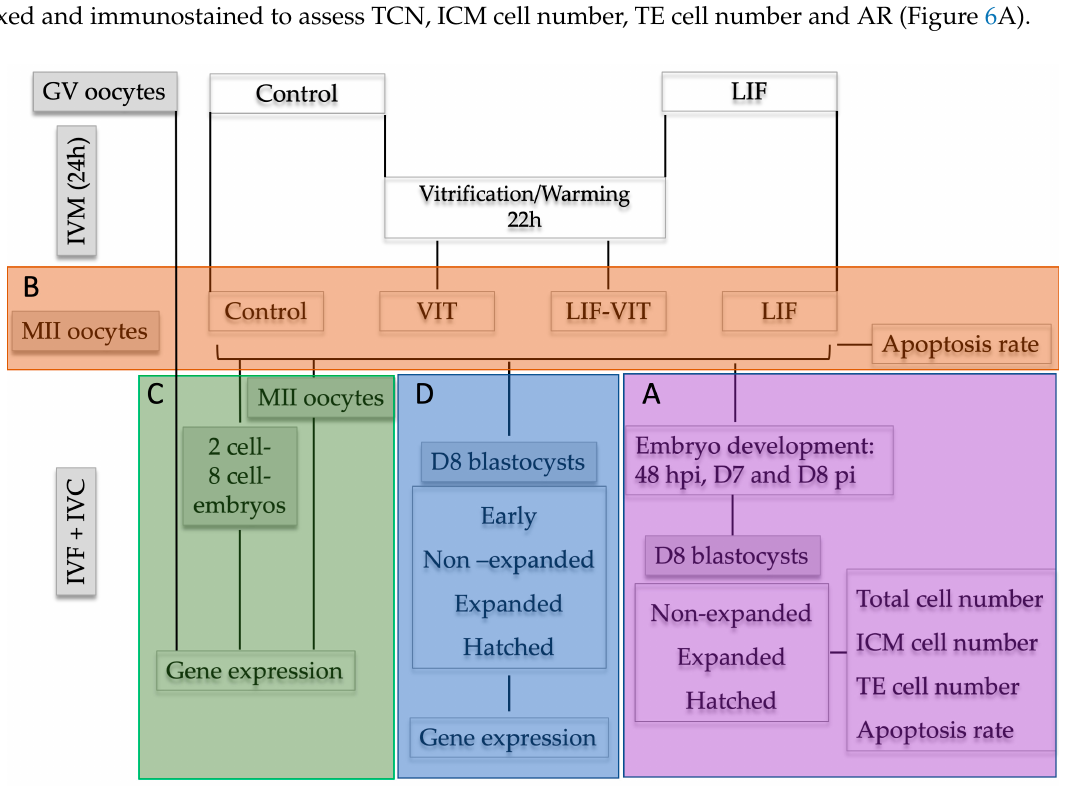
Figure 6. Experimental design. Upon oocyte collection, immature cumulus-oocyte complexes (COCs) were randomly divided into two experimental groups: ( A ) control group: oocytes were in vitro-matured as previously described; and ( B ) LIF group: oocytes were in vitro matured using the same IVM medium supplemented with human recombinant LIF (25 ng / mL). After 22 h, half of the in vitro-matured oocytes from Control and LIF groups were vitrified / warmed and allowed to recover for 2 h (VIT and LIF-VIT groups, respectively). Experimental group ( A ): Oocytes were in vitro fertilized and cultured. Cleavage rates were assessed at 48 hpi and blastocyst rates on Day 7 and Day 8 pi. D8 embryos were classified in non-expanded, expanded and hatched blastocysts and immunostained to assess TCN, ICM cell number, TE cell number and AR. Experimental group ( B ): At 24 h of IVM, oocytes were denuded and immunostained to assess the percentage of apoptosis by TUNEL assay. Experimental group ( C ): GV oocytes collected a 0 h, and MII oocytes, 2-cell and 8-cell embryos collected from each group at 24 h of IVM, 31–33 hpi and 52–54 hpi, respectively, were stored at − 80 ◦ C for RT-qPCR analysis. Experimental group ( D ): Oocytes were in vitro fertilized and cultured up to day 8 pi. Day 8 embryos were classified as early, non-expanded, expanded and hatched blastocysts and stored at 80 ◦ C for RT-qPCR analysis.